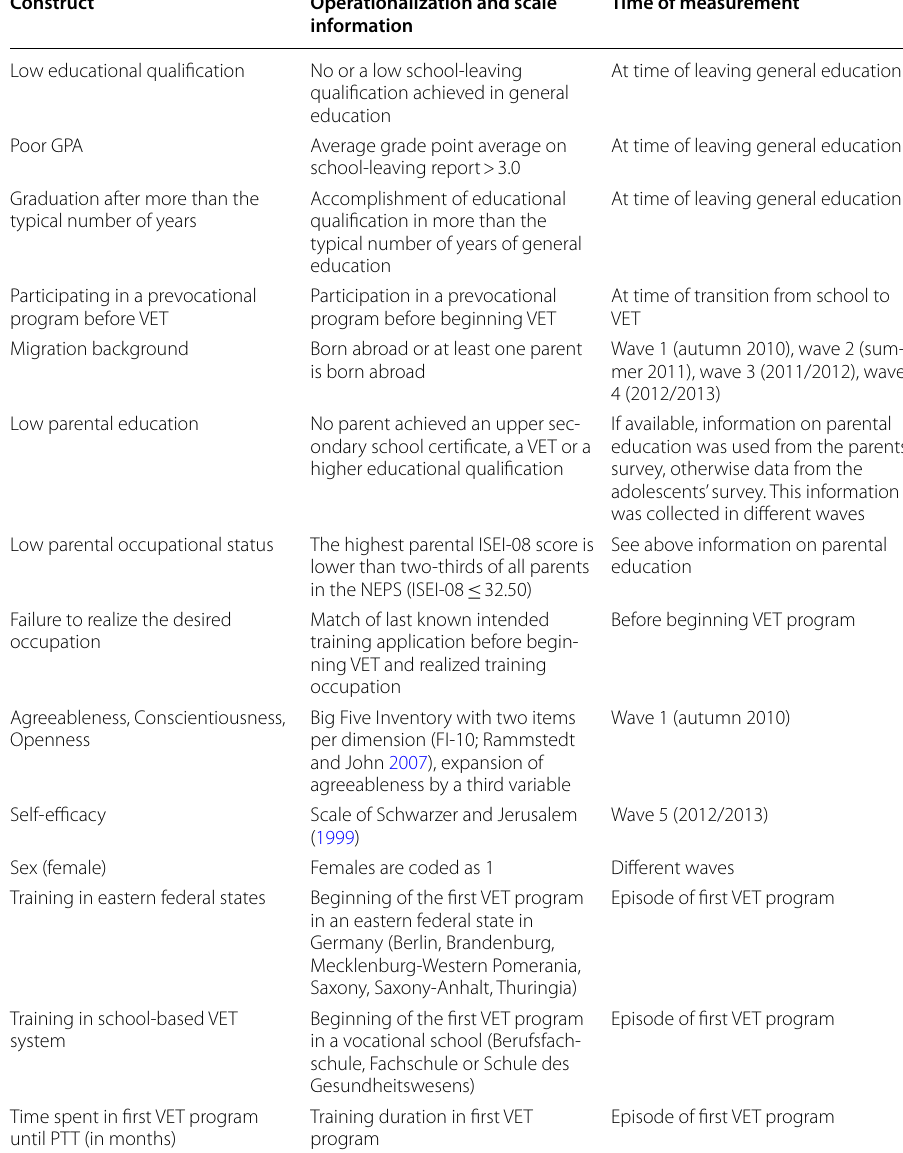
Table 1 Descriptions of independent and control variables Construct Operationalization and scale